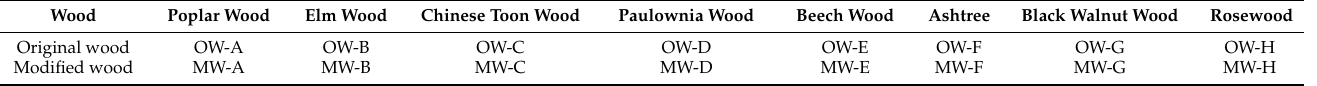
Table 1. Serial numbers of wood before and after